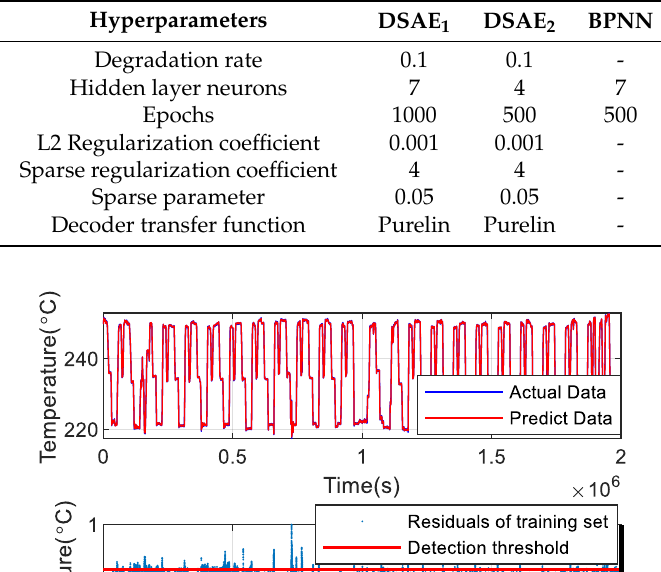
Table 2. Parameters setting of SDSAE-BP network